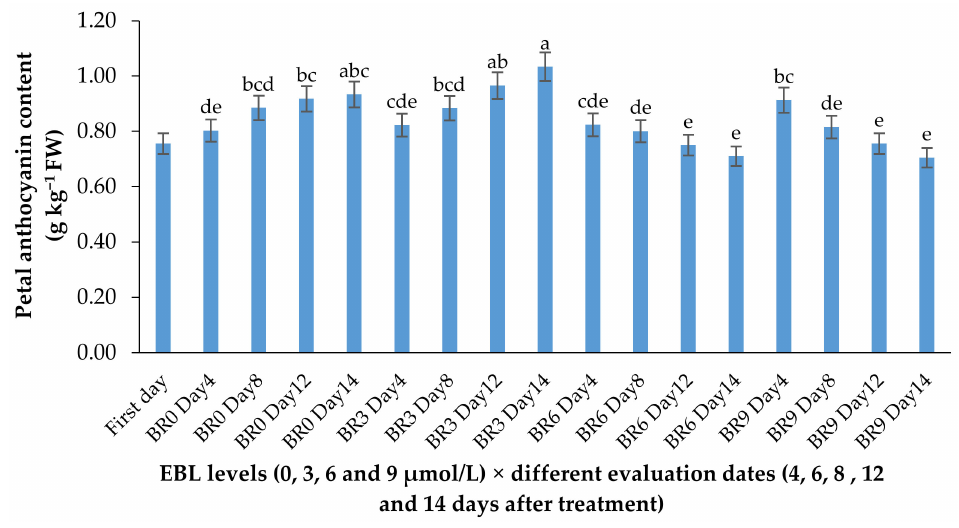
Figure 5. Effect of EBL on anthocyanin content of lisianthus flowers at different evaluation dates. Error bars represent the standard error of means of four replicates. Columns indicated by different letters are significantly different according to Duncan’s multiple range test ( p ≤ 0.01). The first day is the harvest time of samples.